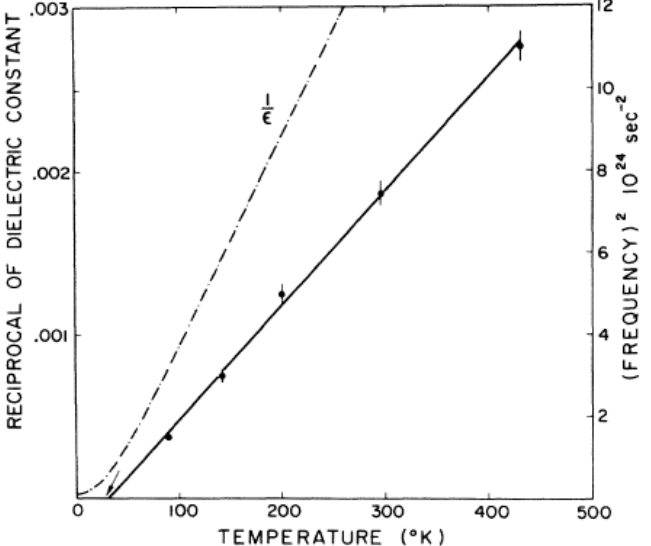
Figure 29. A plot of the square of the frequency of the q = 0 transverse optic mode against temperature in SrTiO 3 . The solid line is a linear regression fit through the points and gives a Curie temperature of 32 ± 5 K. The dashed line represents the reciprocal of the dielectric constant. This figure is taken from Figure 3 of ref. [76]. Copyright by the American Physical